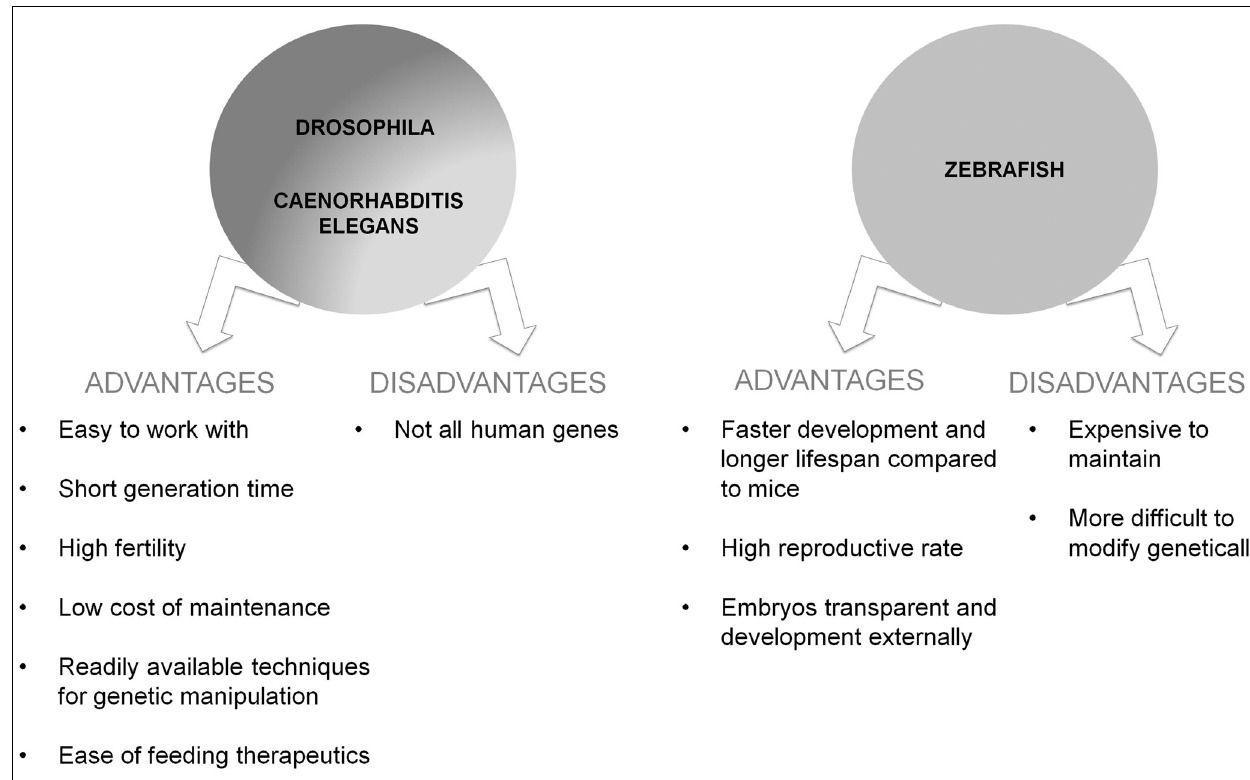
FIGURE 3 | Schematic representation of advantages and disadvantages of the use of the vertebrate and invertebrate models